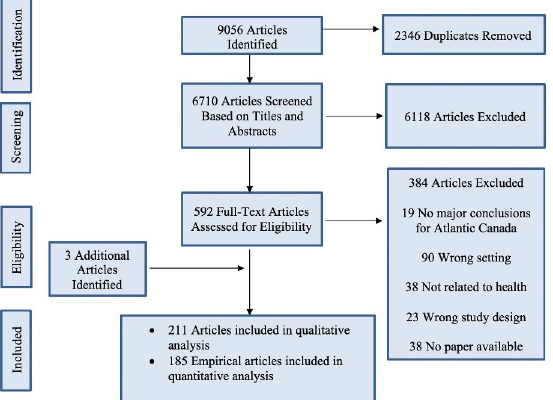
Fig 1. Preferred reporting items for systematic review and meta-analysis (PRISMA) flow diagram